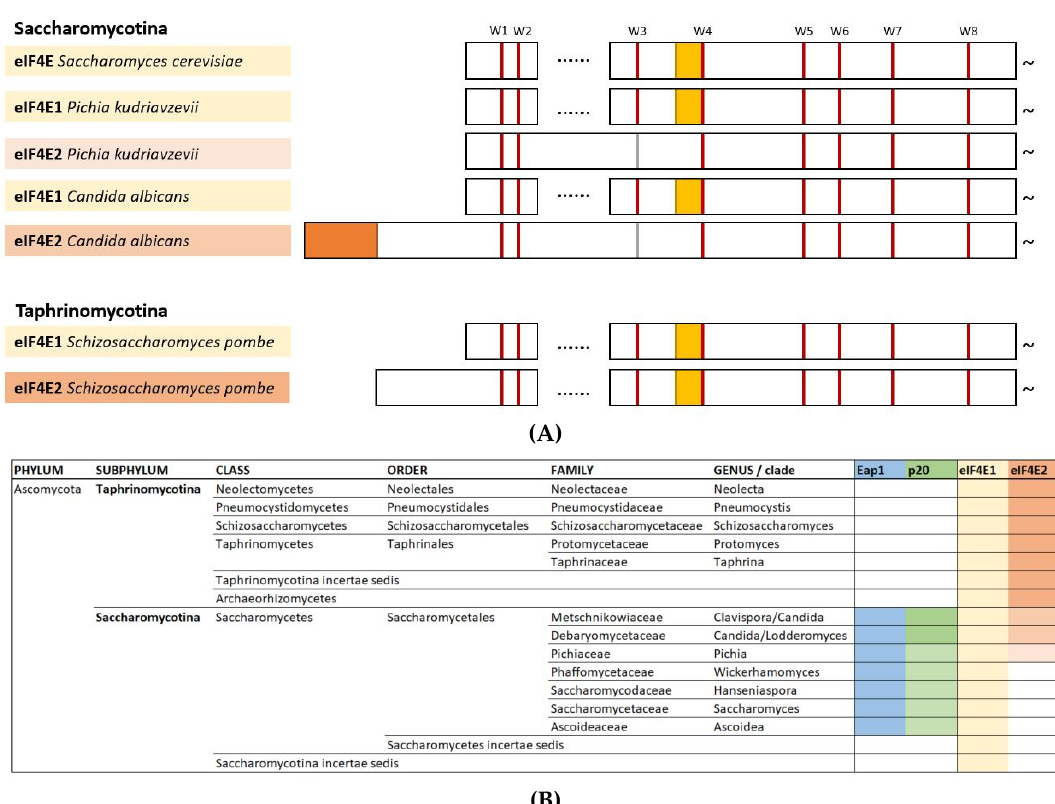
Figure 2. ( A ) Scheme representing the core of different yeast eIF4E1 and eIF4E2 including the eight conserved tryptophane residues W1 to W8 (labelled in red), substitutions of W3 for Y (labelled in grey). Highlighted in orange is the conserved aminoterminus (motif MSENLKRAESLFNRIMN) found in several eIF4E2s of Saccharomycotina species, marked in yellow is the helix-forming motif S/TVxxF adjacent to W4 of all shown yeast eIF4E1 and S. pombe eIF4E2 (but not conserved in Saccharomycotina eIF4E2s). ( B ) Phylogenetic summary of eIF4E1, eIF4E2, Eap1, and p20 from yeast species of different subphyla and families. i) Eap1 containing species are marked in blue; ii) p20 containing species in dark green for families Metschnikowiaceae or Debaryomycetaceae and light green for families Pichiaceae, Phaffomycetaceae, Saccharomycodaceae, Saccharomycetaceae, and Ascoideaceae. iii) eIF4E1 (yellow) is present in all species; iv) eIF4E2 containing species from Taphrinomycotina (dark orange), from families Metschnikowiaceae or Debaryomycetaceae (light orange) and from Pichiaceae (salmon).